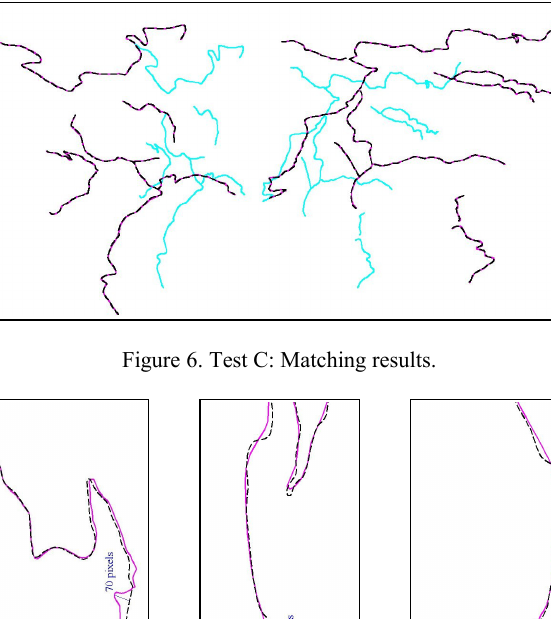
Figure 5. Test B: Matching results.